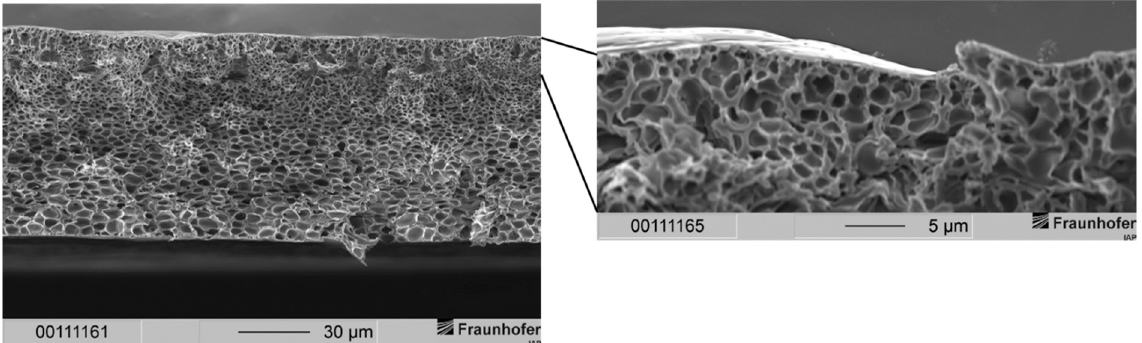
Figure 7. ( Left ) Cross-section of a non-layered PSU flat sheet membrane fabricated according to conditions shown in Table 2. The precipitation medium was distilled water. ( Right ) Enlarged view of the top layer with dense separation layer and sponge-like support structure.